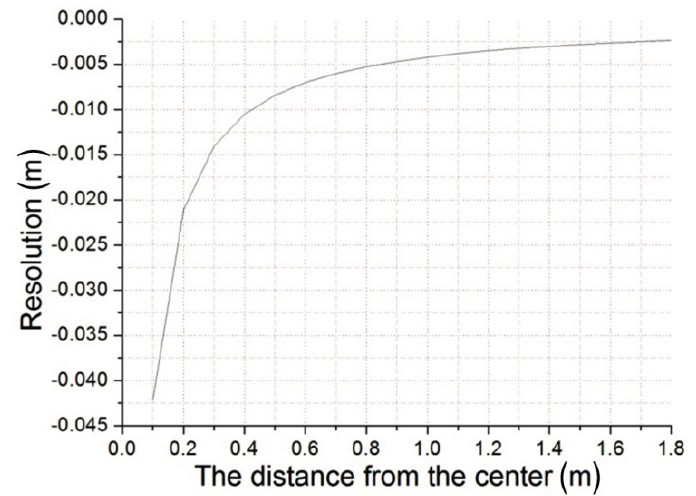
Figure 9. The relation of the resolution with the distance from the